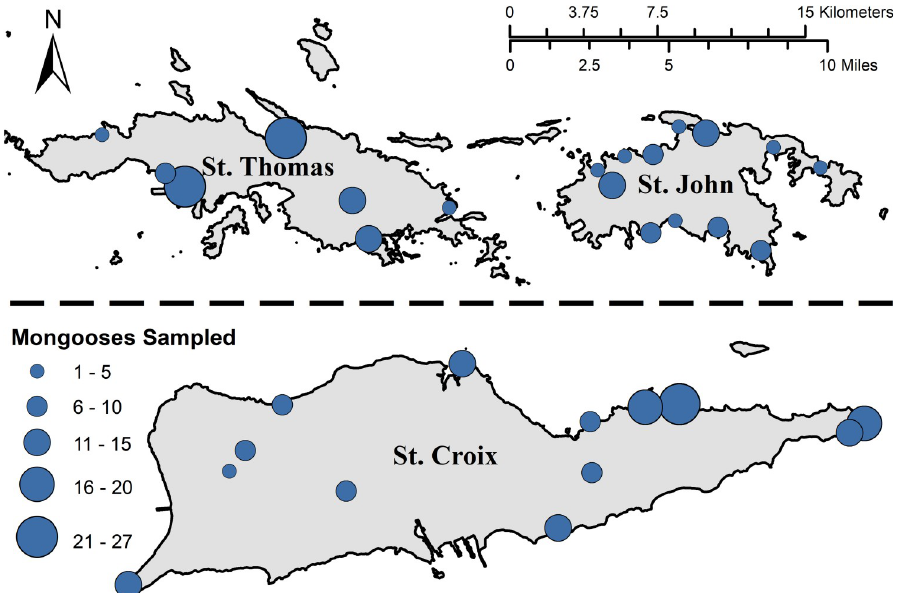
Fig 3. Location and number of small Indian mongooses ( Urva auropunctata ) sampled (n = 312) for rabies antibody and antigen—United States Virgin Islands, 2019–2020. All mongoose serum and brain samples tested negative for rabies antibody by using the rapid fluorescent focus inhibition test, and rabies antigen by using the direct fluorescent antibody test, respectively. Map base layer was obtained from https://www.sciencebase.gov/catalog/item/ 5ae3f8ede4b0e2c2dd320df8.